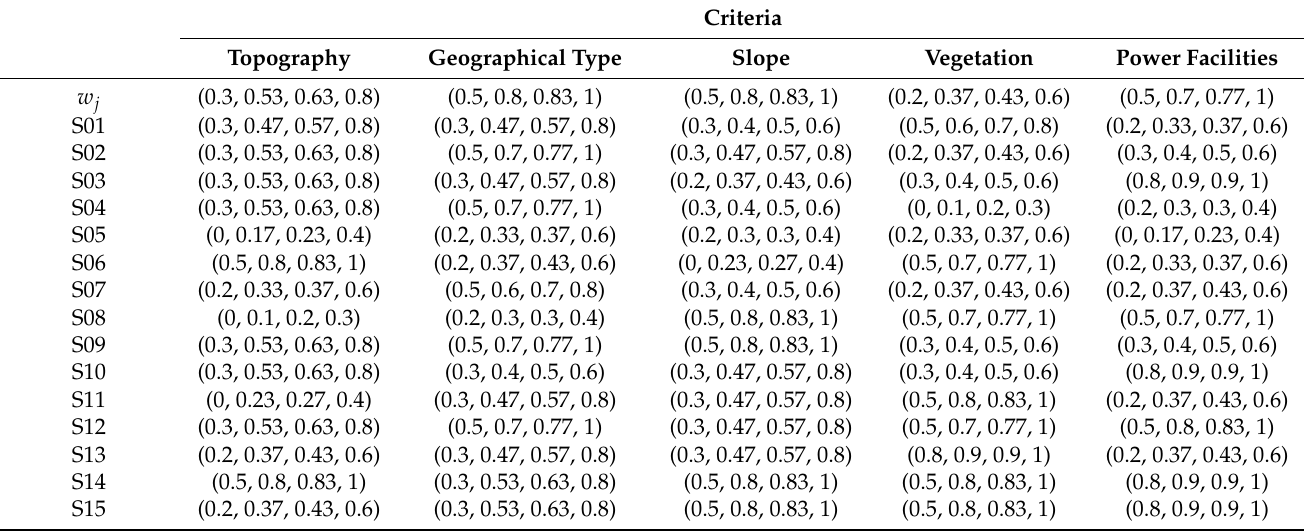
Table 13. The normalized values of weights and the candidate shelter rate.